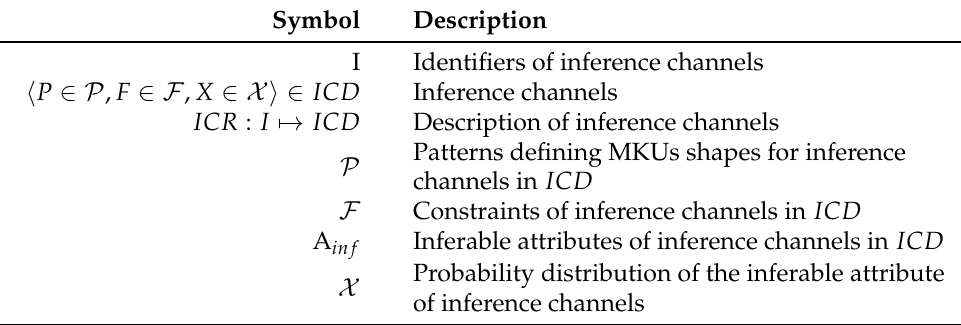
Table 2. Symbols defined to model inference channels in